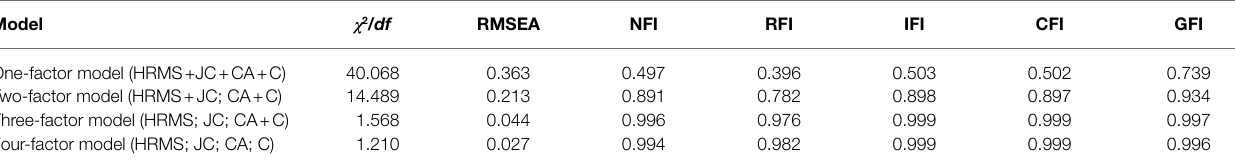
TABLE 1 | Confirmatory factor analysis. Model